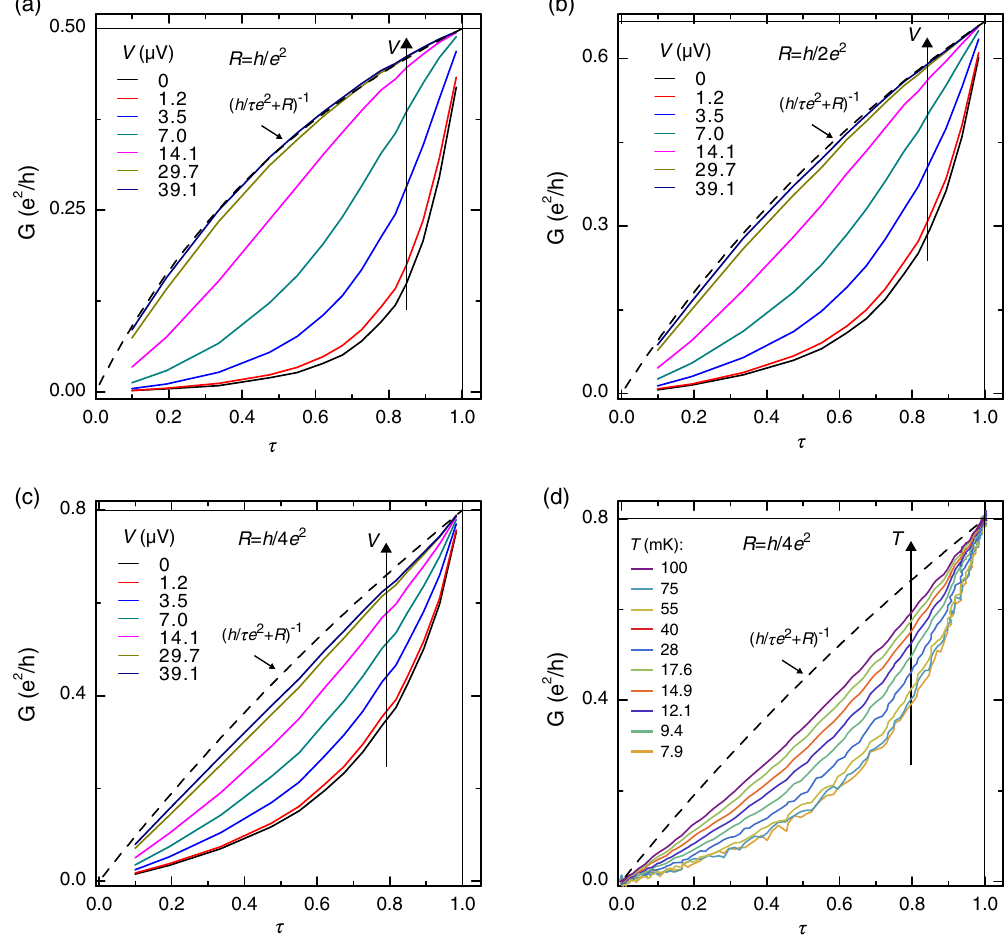
FIG. 5. Quantum phase transition between metallic and insulating states. (a),(b),(c) Colored continuous lines display the device ’ s conductance G ¼ dI=dV measured at T ¼ 7 . 7 mK and different dc bias voltage V for a series resistance set to R ¼ f 1 ; 1 = 2 ; 1 = 4 g × h=e 2 ( K ¼ f 1 = 2 ; 2 = 3 ; 4 = 5 g ). The data are plotted versus bare transmission probability τ . (d) Colored continuous lines display G ¼ dI=dV measured at V ¼ 0 for different T and a series resistance set to R ¼ h= 4 e 2 ( K ¼ 4 = 5 ) versus bare transmission probability τ . Whatever K ( R ), the conductance progressively vanishes as V or T is reduced except at the ballistic quantum critical point τ ¼ 1